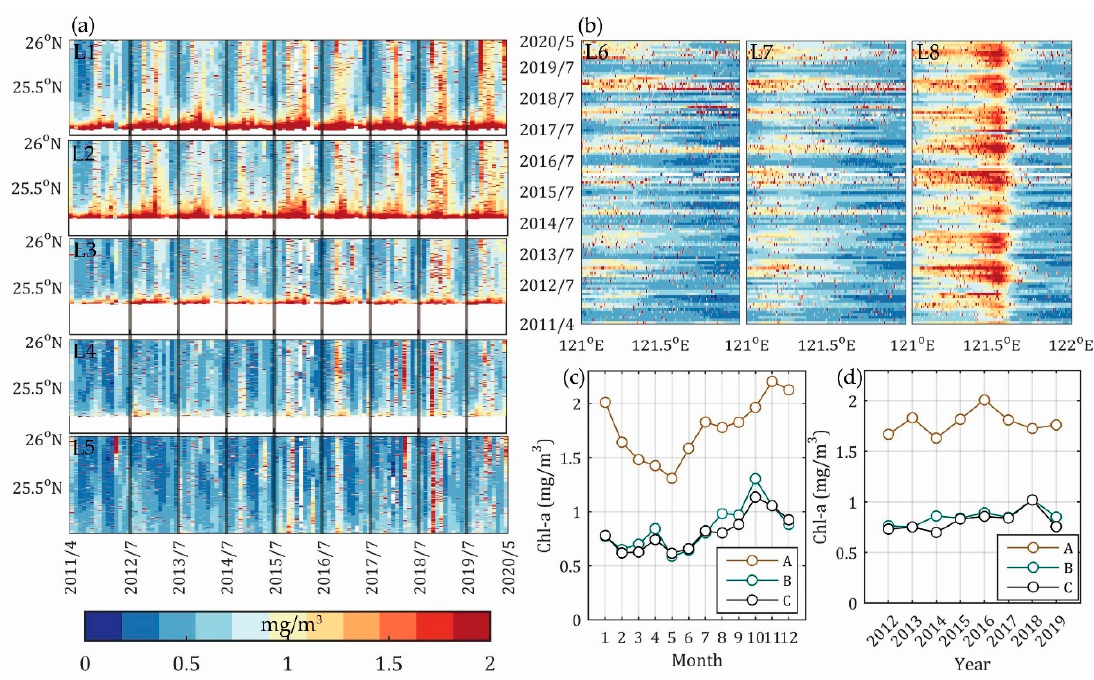
Figure 12. Monthly to seasonal variations in the chlorophyll concentration. ( a ) L1 to L5 sections, ( b ) L6 to L8 sections, ( c , d ) monthly and yearly means of the three areas in Figure 11a.